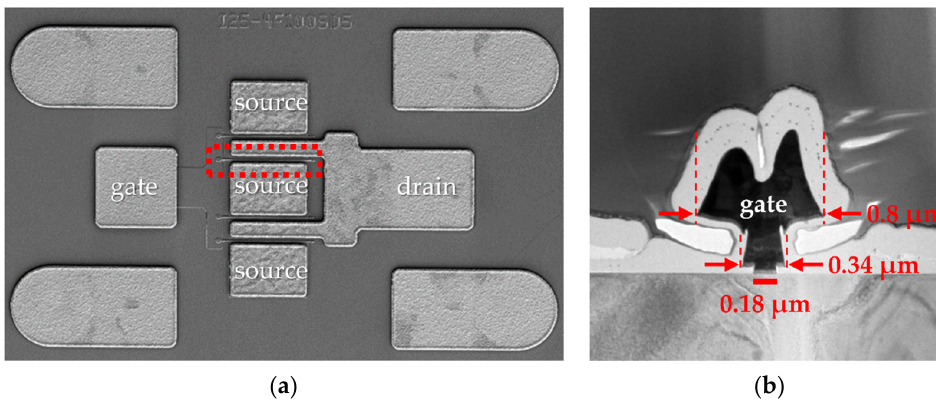
Figure 1. Scanning electron microscope (SEM) images of the fabricated AlGaN/GaN high-electron- mobility transistor (HEMT) structure: ( a ) top view of a four-finger transistor device and red dashed frame shows the representative one-finger gate electrode; ( b ) cross-sectional view of a basic T-gate electrode.